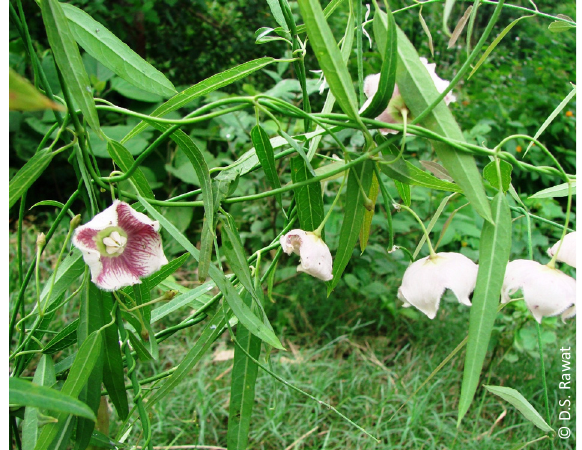
Image 8. Oxystelma esculentum (L.f.)